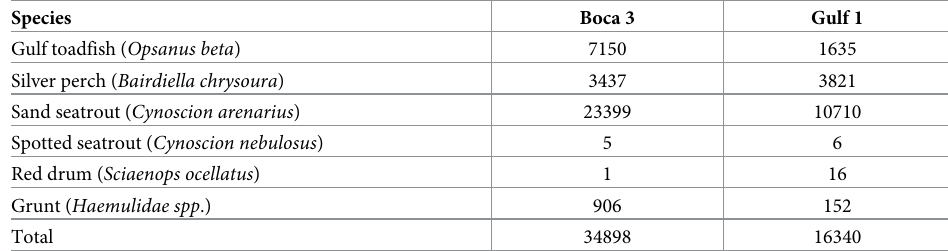
Table 3. List of fish species detected at Boca 3 and Gulf